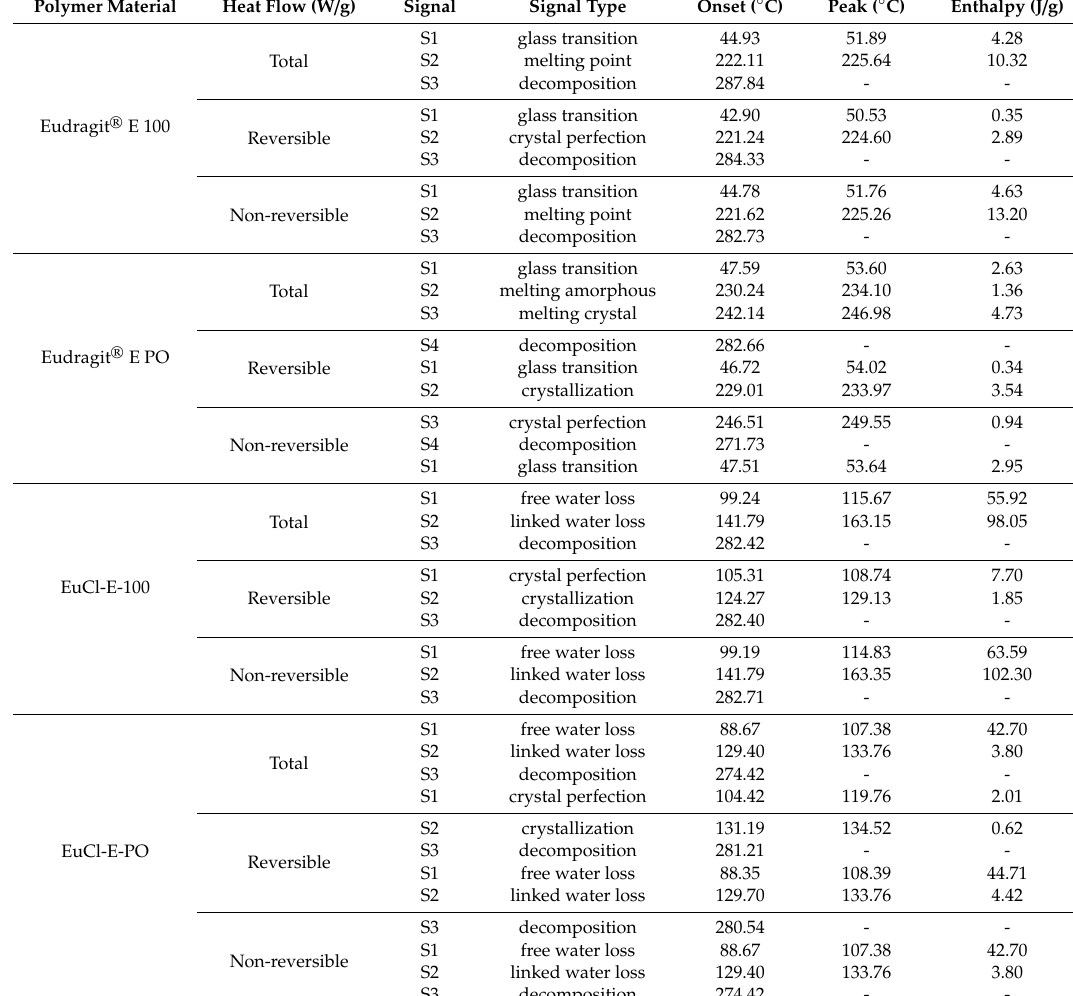
Table 3. Summary data for the modulated DSC analysis for Eudragit ® polymers and EuCl derivatives. Polymer Material